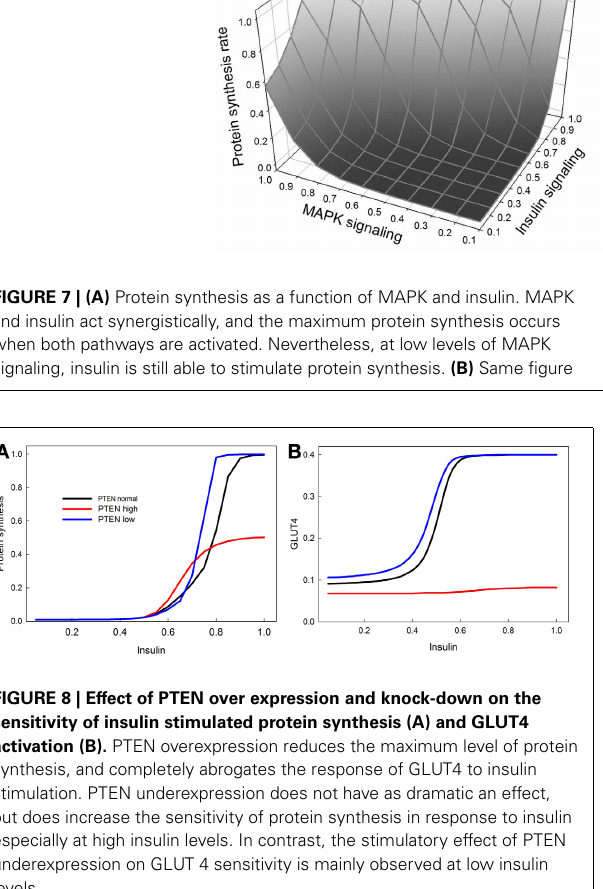
FIGURE 8 | Effect of PTEN over expression and knock-down on the sensitivity of insulin stimulated protein synthesis (A) and GLUT4 activation (B). PTEN overexpression reduces the maximum level of protein synthesis, and completely abrogates the response of GLUT4 to insulin stimulation. PTEN underexpression does not have as dramatic an effect, but does increase the sensitivity of protein synthesis in response to insulin especially at high insulin levels. In contrast, the stimulatory effect of PTEN underexpression on GLUT 4 sensitivity is mainly observed at low insulin